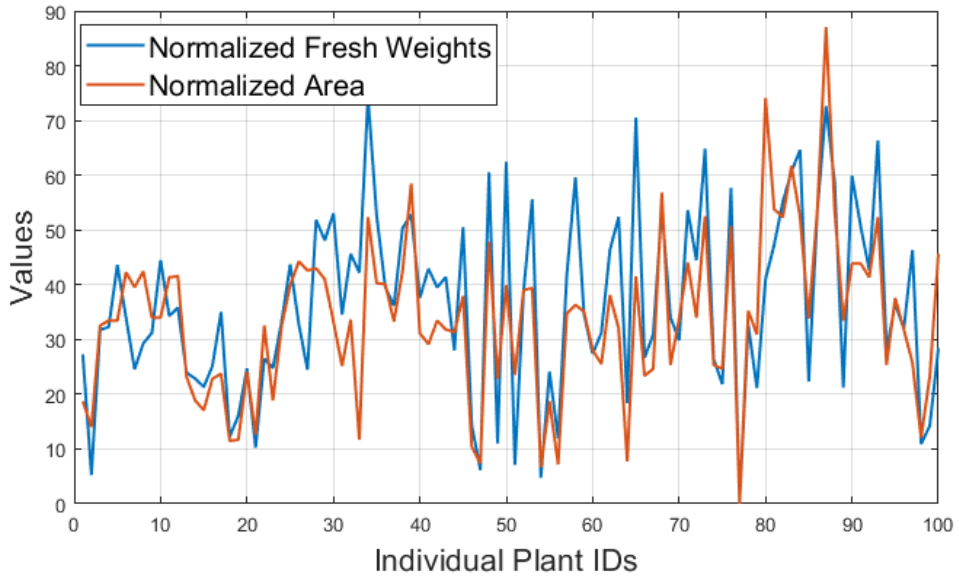
Figure 13. Comparisons between the individual plant values of normalized values of fresh weights and areas for first 100 plants in a same range of [0, 100] for the field trial image taken on 5 July 2017.